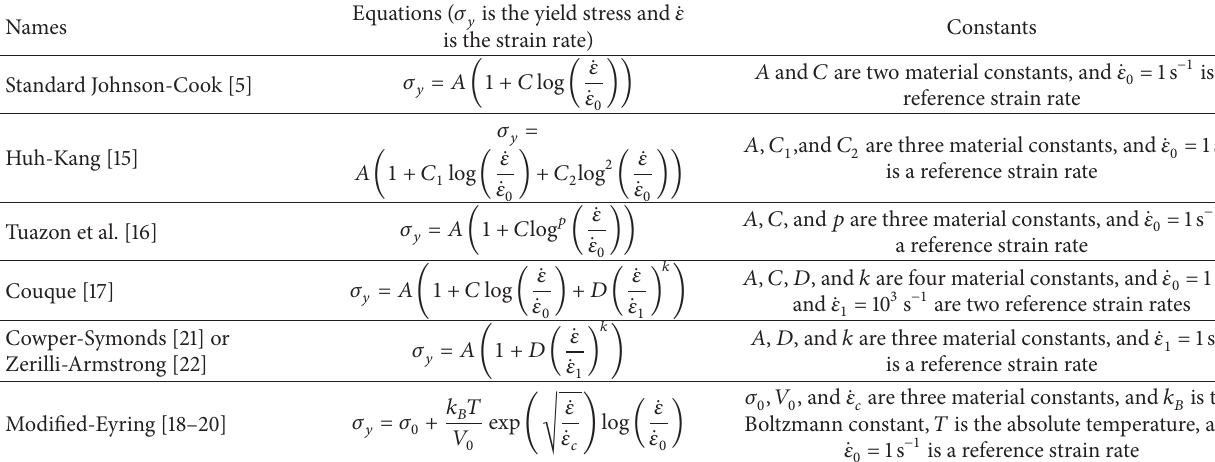
Table 1: Constitutive